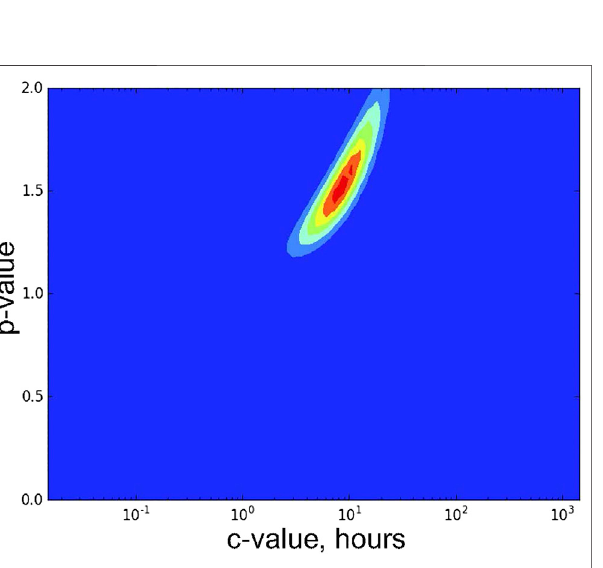
Frontiers in Earth Science |